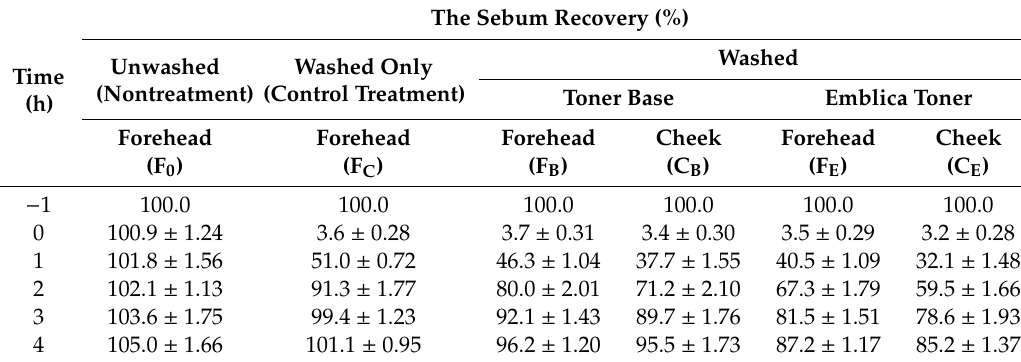
Table A3. Area under the curve (AUC) of sebum recovery on the forehead and cheek skin (F C , F B , F E , C B , C E ) at 1, 2, 3, and 4 h of 30